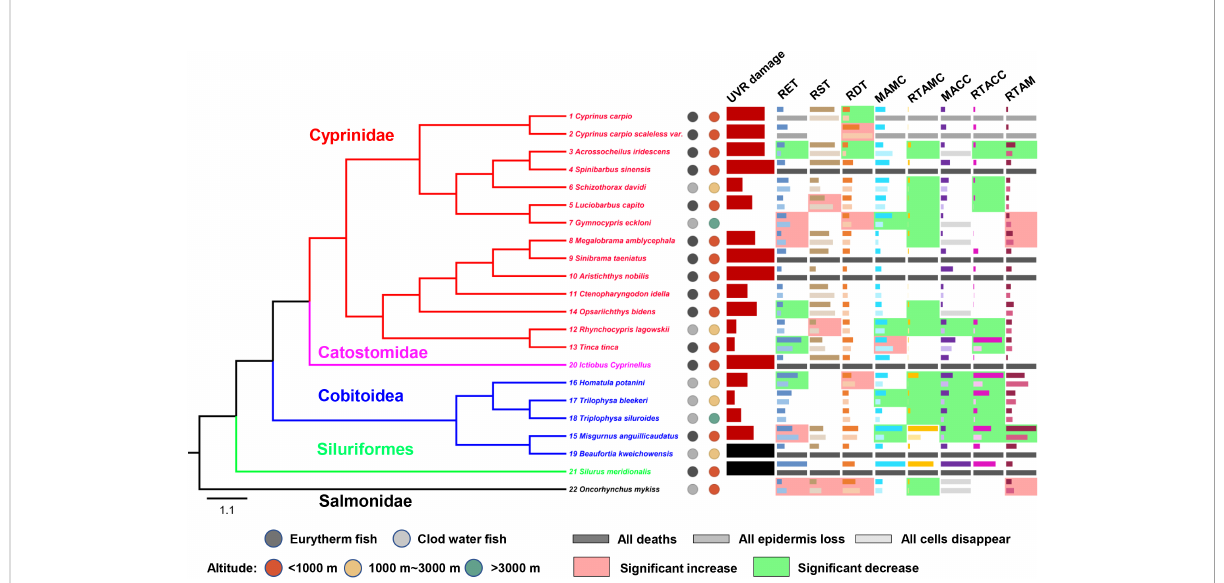
FIGURE 3 Interspeci fi c differences in UVR damage and skin histological changes of experimental fi shes. The black column for UVR damage indicates species that died but had no obvious skin damage and were thus excluded from subsequent analyses. For each skin histological indicator (mean, standardized by the maximum), the dark columns represent the values of the control groups, and the light columns represent the values of the experimental groups. The light red/green background represents a signi fi cant increase/decrease (P<0.05) after UVR exposure. The number before the Latin binomial is the serial number of the corresponding species. RET, the relative epidermal thickness; RST, the relative scale thickness; RDT, the relative dermal thickness; MAMC, the mean area of mucus cells; MACC, the mean area of club cells; RTAMC, the relative total area of mucous cells; RTACC, the relative total area of club